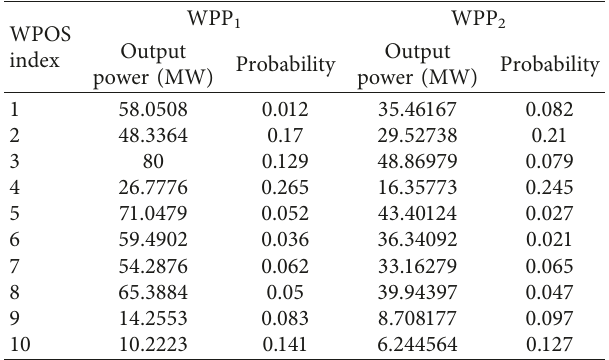
Figure 1: Diagram of the test system. Note . Figure 1 is reproduced from [41] (under the Creative Commons Attribution License/public domain). For the sake of simplicity, here it is assumed that the minimum and maximum congestion constraints in all transmission lines are ± 40MW. Table 1: Reduced 10 real-time WPOSs and their corresponding probabilities of these two WPPs.